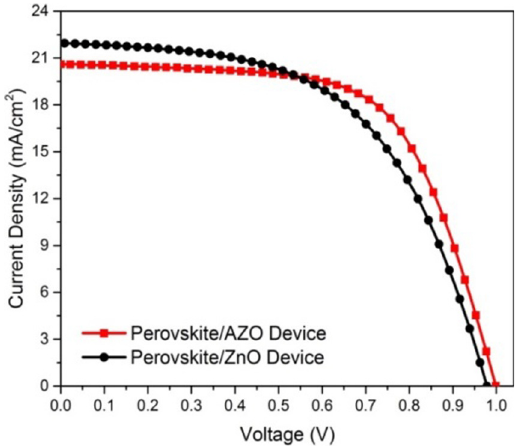
Fig. 4. Recombination resistance ( fi tted data from impedance spectroscopy at 0.9 V under dark) of MA 0.6 FA 0.4 PbI 3 perovskite devices containing ZnO and AZO (Al doped